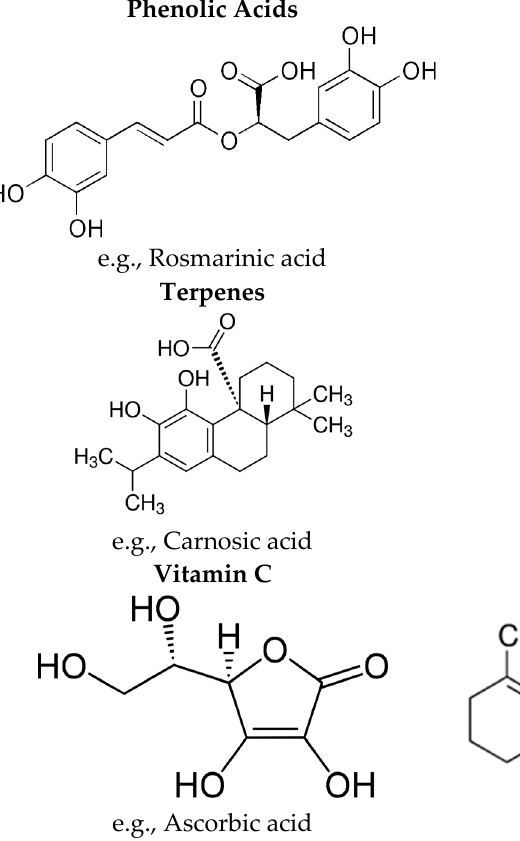
Figure 1. Major antioxidants in medicinal plants.